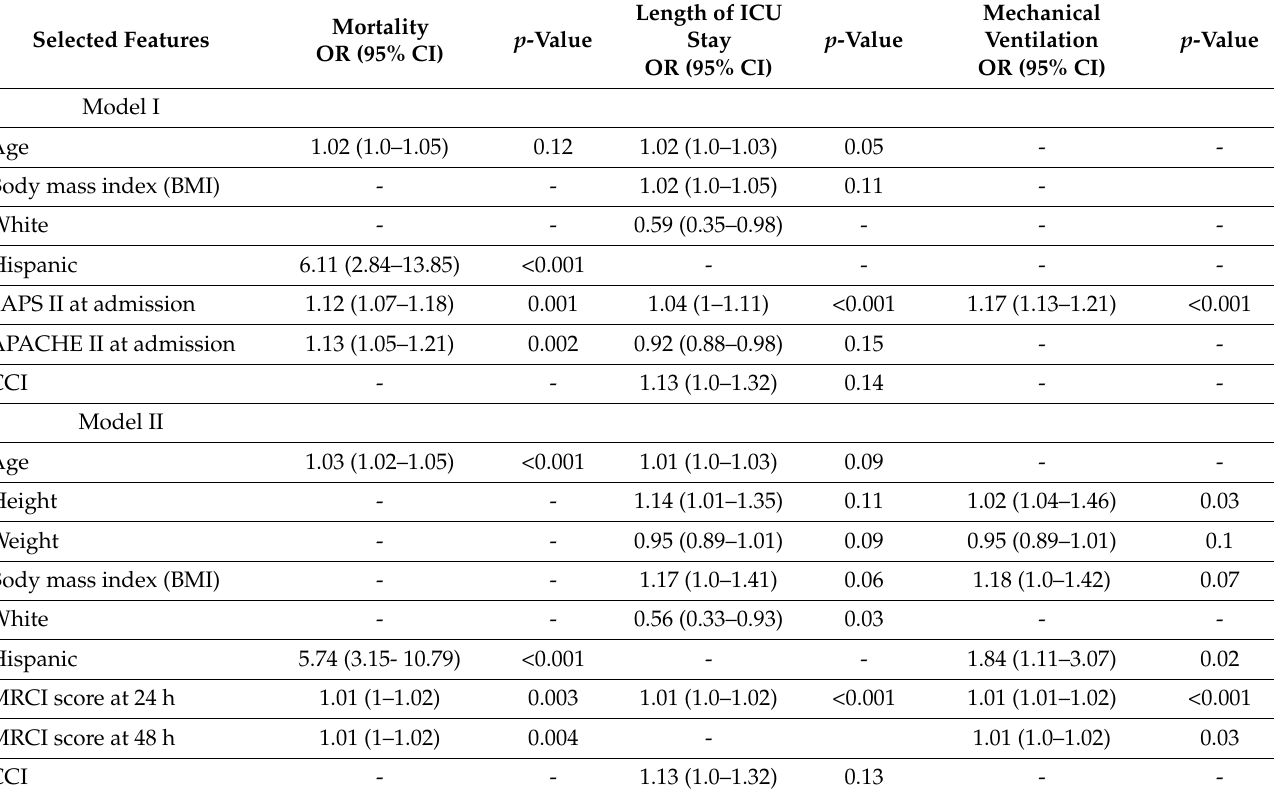
Table 2. Four logistic regression models for three clinical outcomes: mortality, length of ICU stay (LOS), and need for mechanical ventilation (MV). List of selected variables using stepwise selection method for the four logistic regression models and their associations with mortality, LOS, and need for